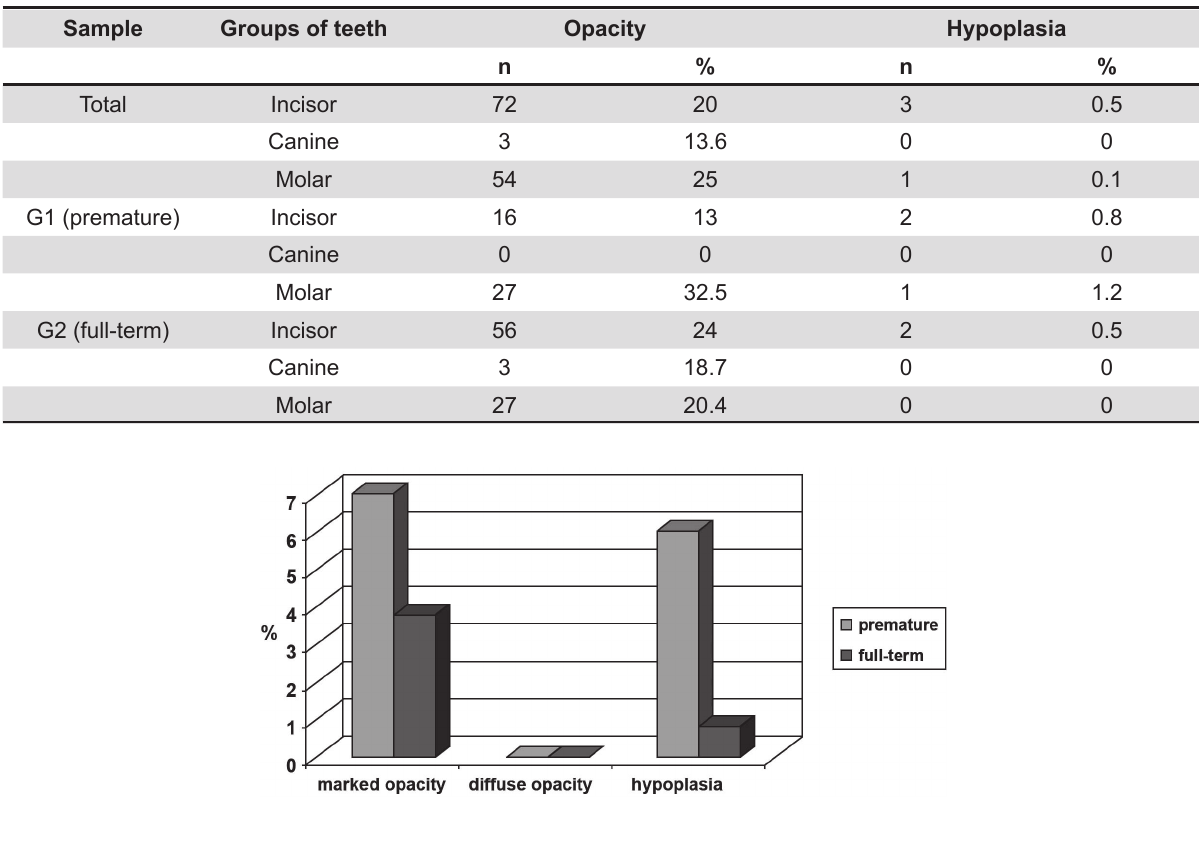
Figure 1- Percentage of marked opacity, diffuse opacity and hypoplasia in primary teeth